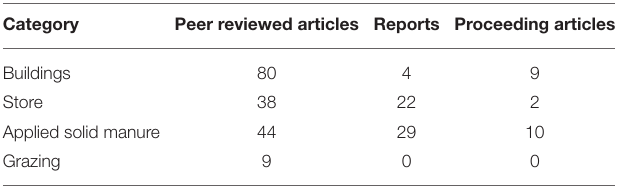
TABLE 3 | Average air temperatures used for the seasonal application of slurry. Region Spring